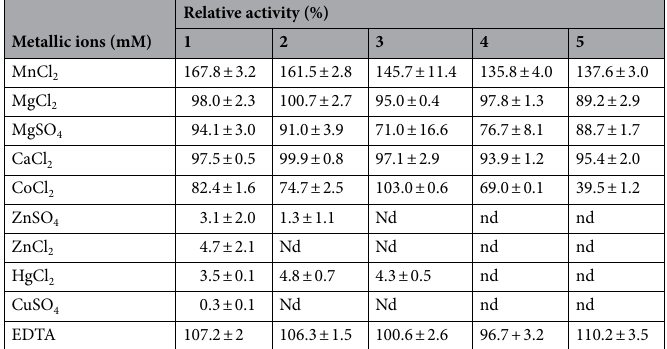
Table 2. Effect of metallic ions, detergents and organic solvents on XylR activity. Values are presented as the mean percentage ± standard deviation; nd = not detected.